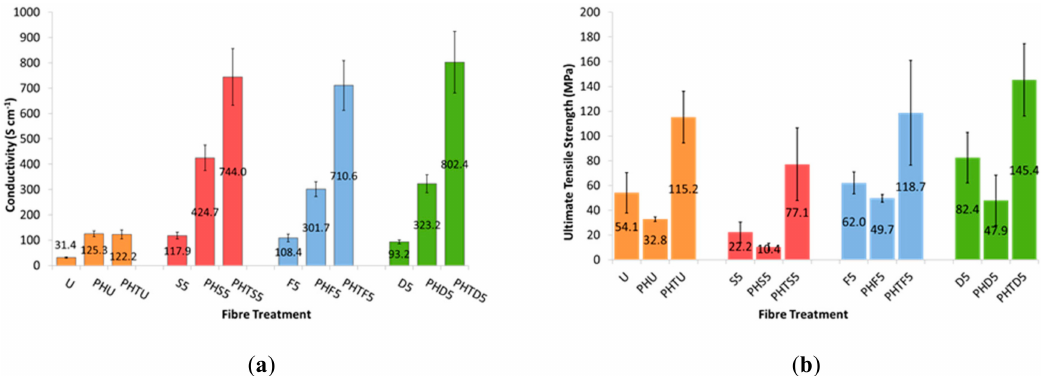
Figure 4. ( a ) Average electrical conductivity measurements and ( b ) average ultimate strength values for all untreated and all 5 min treated fibers; n = 5 in all cases (numbers on bars represent the average values). Average ultimate tensile strength values for all three fiber sizes are also presented in Figure